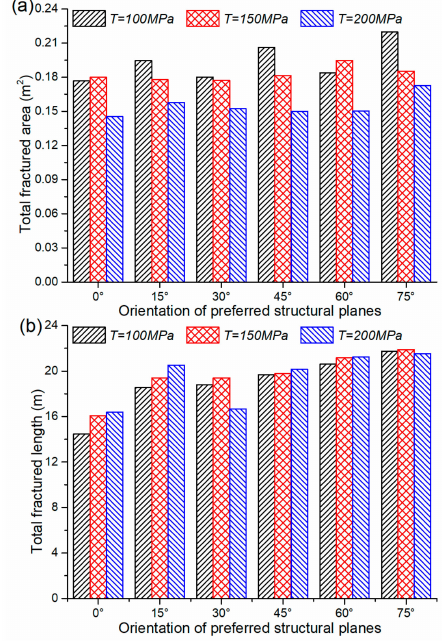
Figure 11. Total fractured area ( a ) and total length of fractures ( b ) for di ff erent compressive strengths. The boundary stress and injection rate were the same as with the base model.